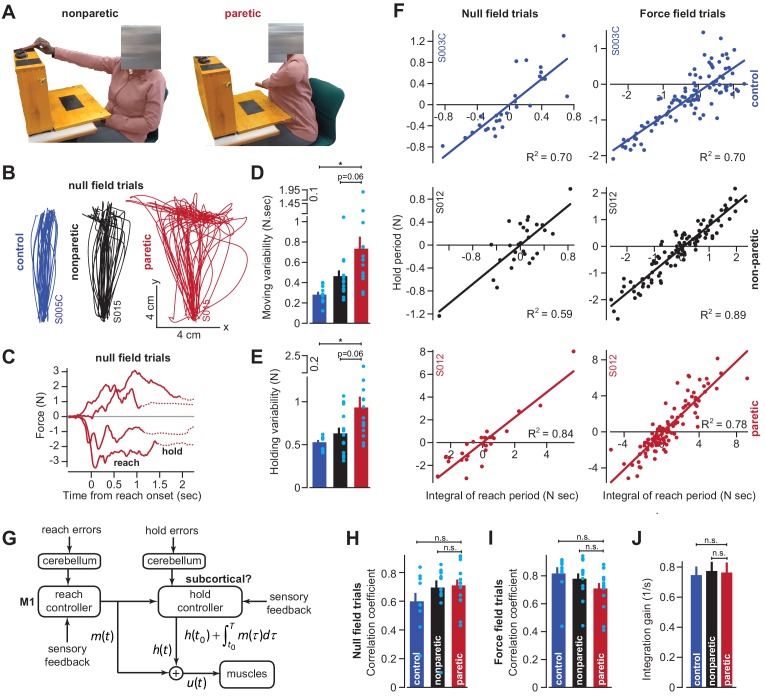
Cortical reaching commands are integrated in a subcortical area.(A) Stroke survivors (n = 14) participated in a set of clinical exams to measure functional impairment. Shown are isolated images for an extension-based task, for the non-paretic (top) and paretic (bottom) arms of an example participant (S015). The instruction is to place a rectangular block on the elevated surface. Images show the moment of maximal extension for the paretic (right) and nonparetic (left) arms. (B) To improve the range of motion of the arm, patients and healthy controls performed reaching movements holding the robotic handle, with the arm supported by an air sled. Shown are example trajectories during an initial null field period for the representative patient (black is nonparetic, red is paretic) in A, and a control participant (blue). (C) Example force traces during null field block in channel trials. The solid line denotes forces during moving. The dashed line denotes forces during holding still. (D and E) We measured the integral of moving forces (D) and holding forces (E) on each channel trial. We measured the trial-by-trial variability (standard deviation) of these quantities across all movements in the null field. (F, H, I, and J) We compared trial-by-trial fluctuations in moving and holding forces during the null field period (F, left panel). Next, we gradually adapted subjects to a velocity-dependent force field and compared within-trial integral of moving forces with subsequent holding force (F, right panel). Data are shown for a representative stroke patient and healthy control. We calculated the correlation coefficient between reaching and holding forces during the initial null field period (H) and force field period (I). We measured the slope of the integration function (i.e., the integration gain) across all trials within individual subjects (J). (G) Our conjecture that the cortex generates reaching commands which are then integrated in a subcortical area spared by cortical stroke. Values are mean ± SEM across participants. Points represent individual trials in F. Points represent individual subjects in D, E, H, and I. Statistics: *p<0.05, and n.s. p>0.05.Figure 7—source data 1.The EXCEL source data file contains holding forces and the integral of moving forces as shown in Figure 7.The data are divided into two tabs, ‘data-null-field-trials’ and ‘data-force-field-trials’. For the former, data are provided for all channel trials appearing in the baseline null field period for the paretic and non-paretic arms of stroke patients, as well as their age-matched controls. For the latter, the same data are provided but for the force field adaptation period. The ‘readme’ tab describes all quantities reported in the two tabs containing participant data.